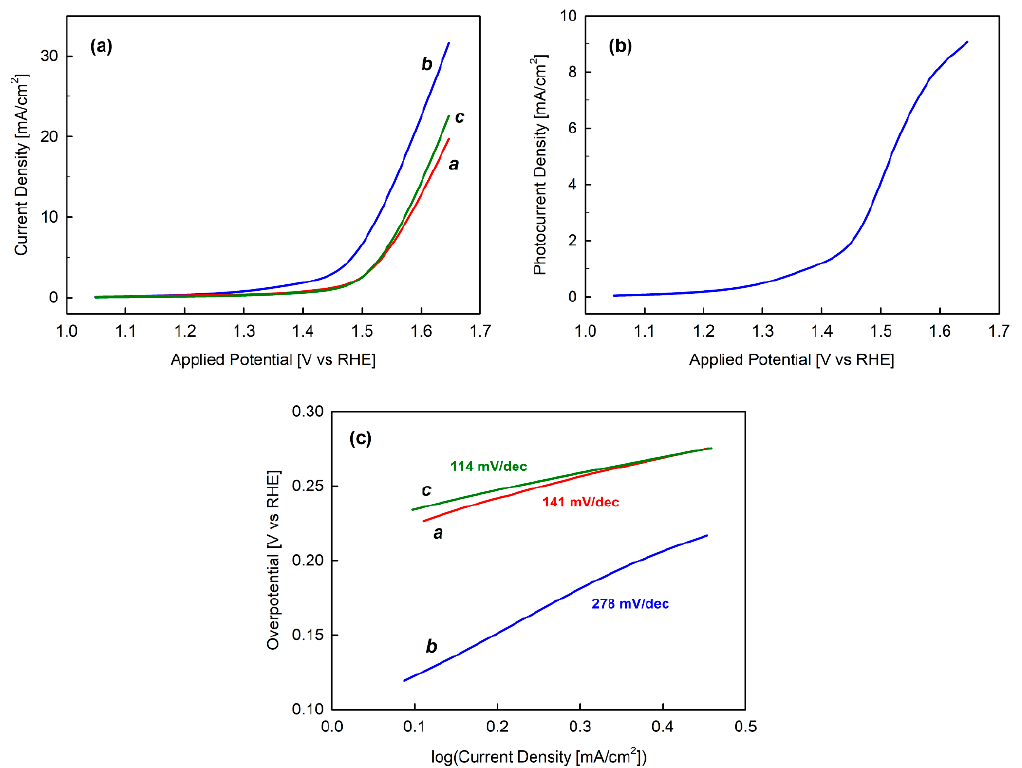
Figure 3. Photoelectrochemical response of the plasma-deposited Ru-based film in the oxygen evolution reaction (OER) process: ( a ) LSV measurements: a − in the dark, b − under illumination, c − in the dark after illumination; ( b ) photocurrent dependence; ( c ) Tafel plots.